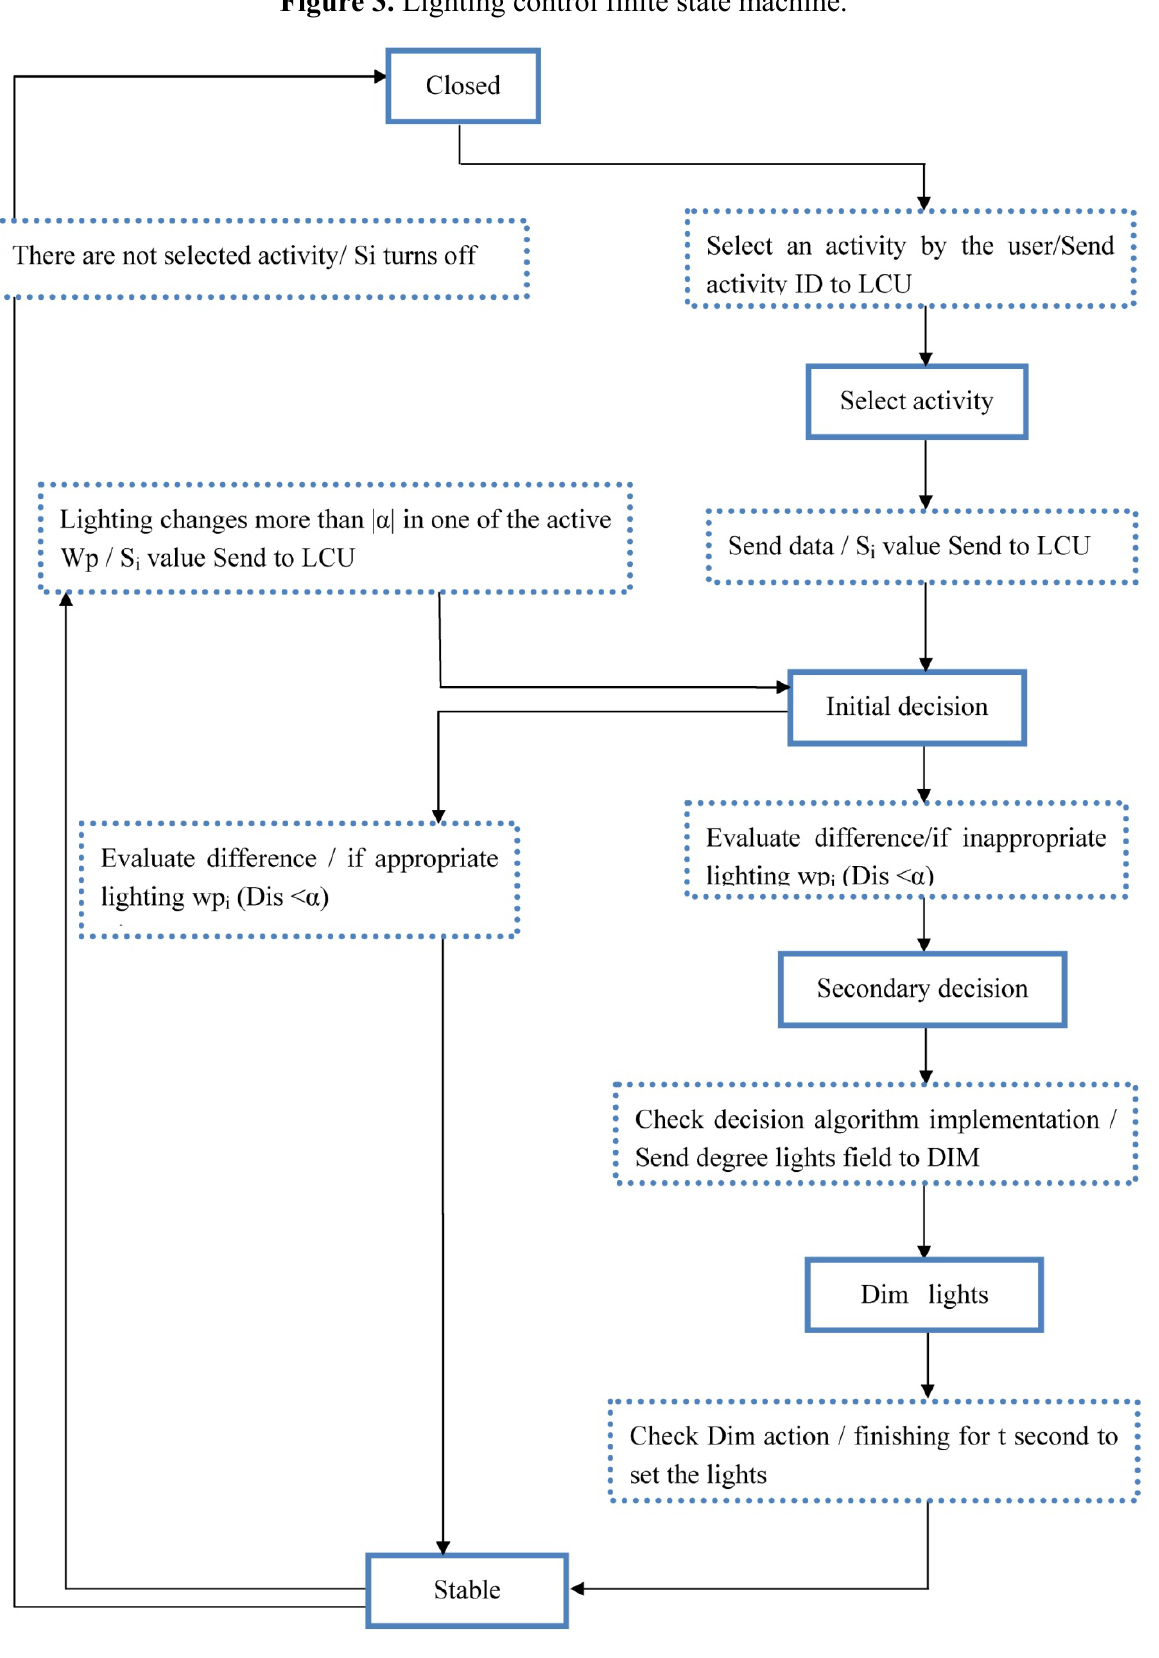
Figure 3. Lighting control finite state